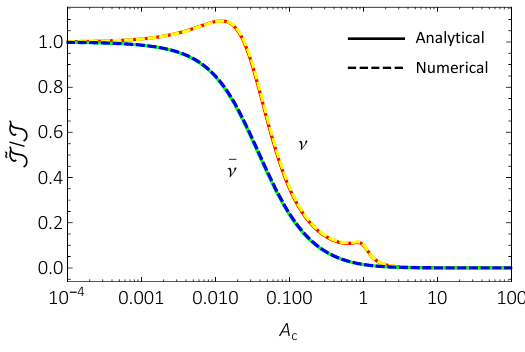
Figure 4 . Analytical and numerical solutions to e (cid:18) input parameters and conventions for the curves are the same as in the previous (cid:12)gures.